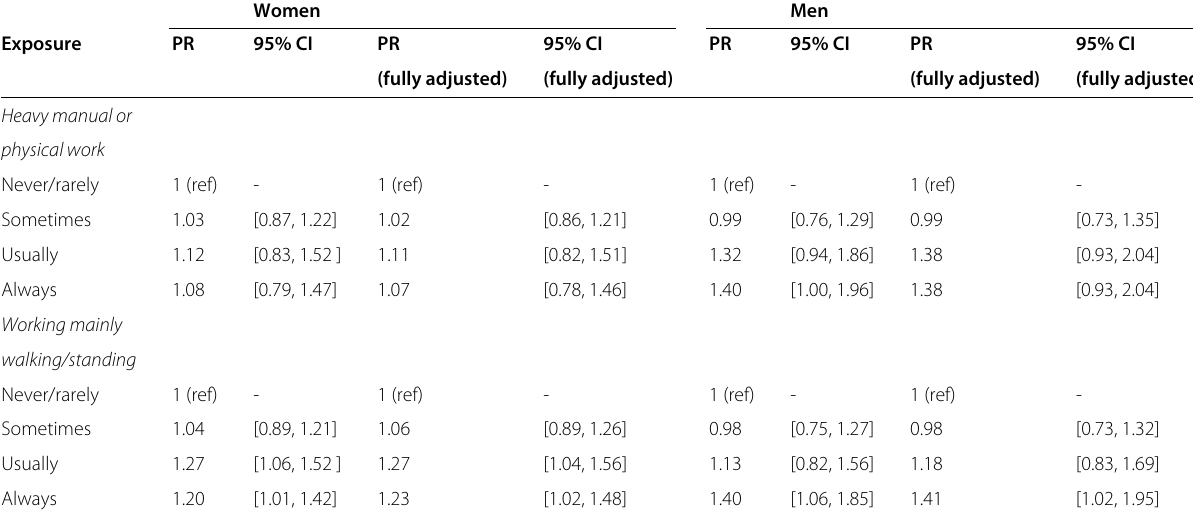
Table 4 Prevalence of migraineurs among different job-related categories (physical activity) Women